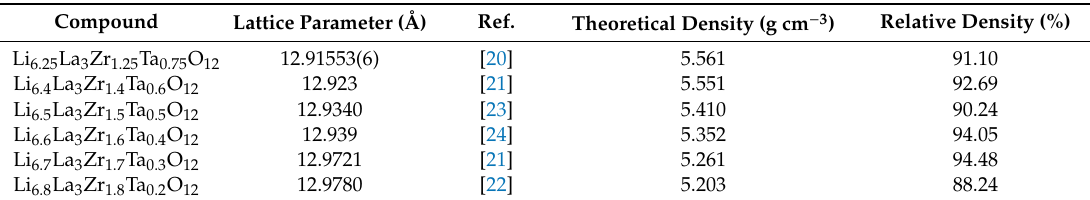
Table 1. Corresponding lattice parameters reported in the literature and the calculated theoretical densities and relative densities of LLZTO.